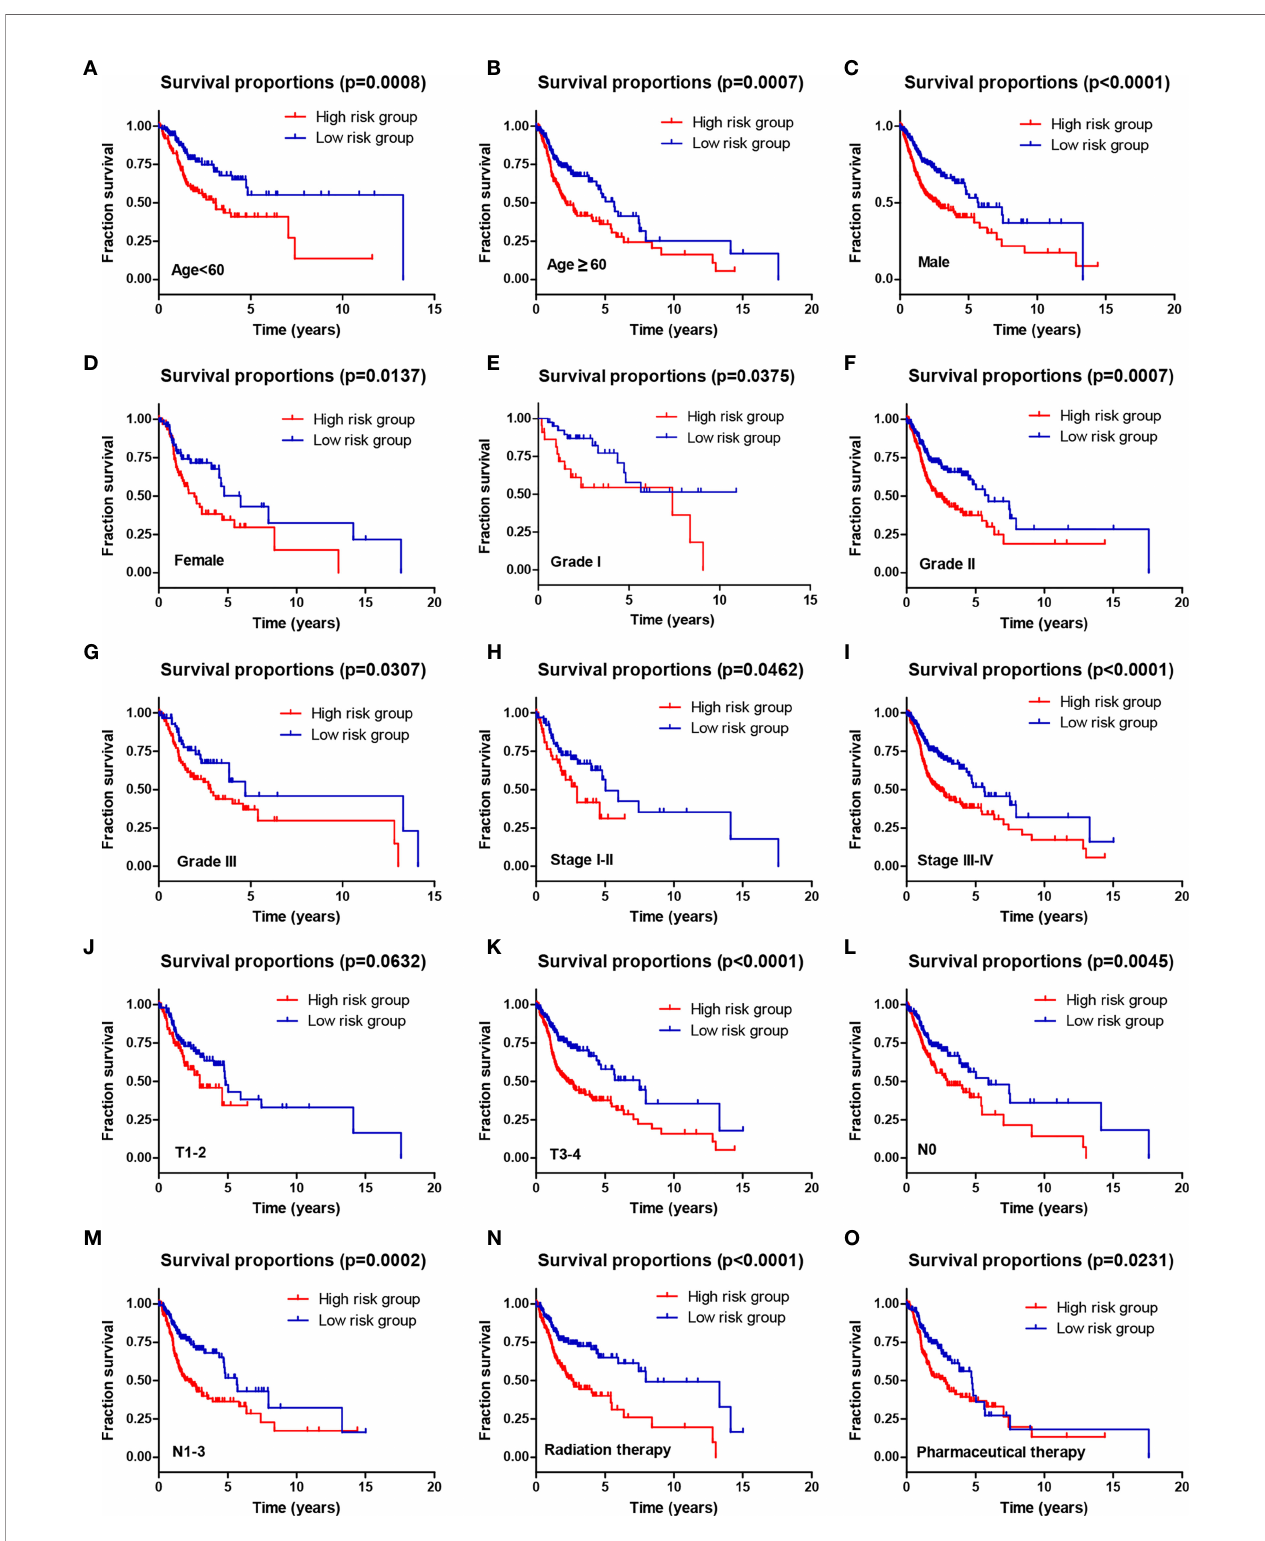
FIGURE 5 | The prognostic ability of the four-AG signature for overall survival in multiple HNSCC subtypes. Kaplan – Meier curves for OS prediction in HNSCC subtypes of (A) Age <60 years, (B) Age ≥ 60 years, (C) Men, (D) Women, (E) Grade I, (F) Grade II, (G) Grade III, (H) Stages I – II, (I) Stages III – IV, (J) T1 – 2, (K) T3 – 4, (L) N0, (M) N1 – 3, (N) Radiation therapy, (O) Pharmaceutical